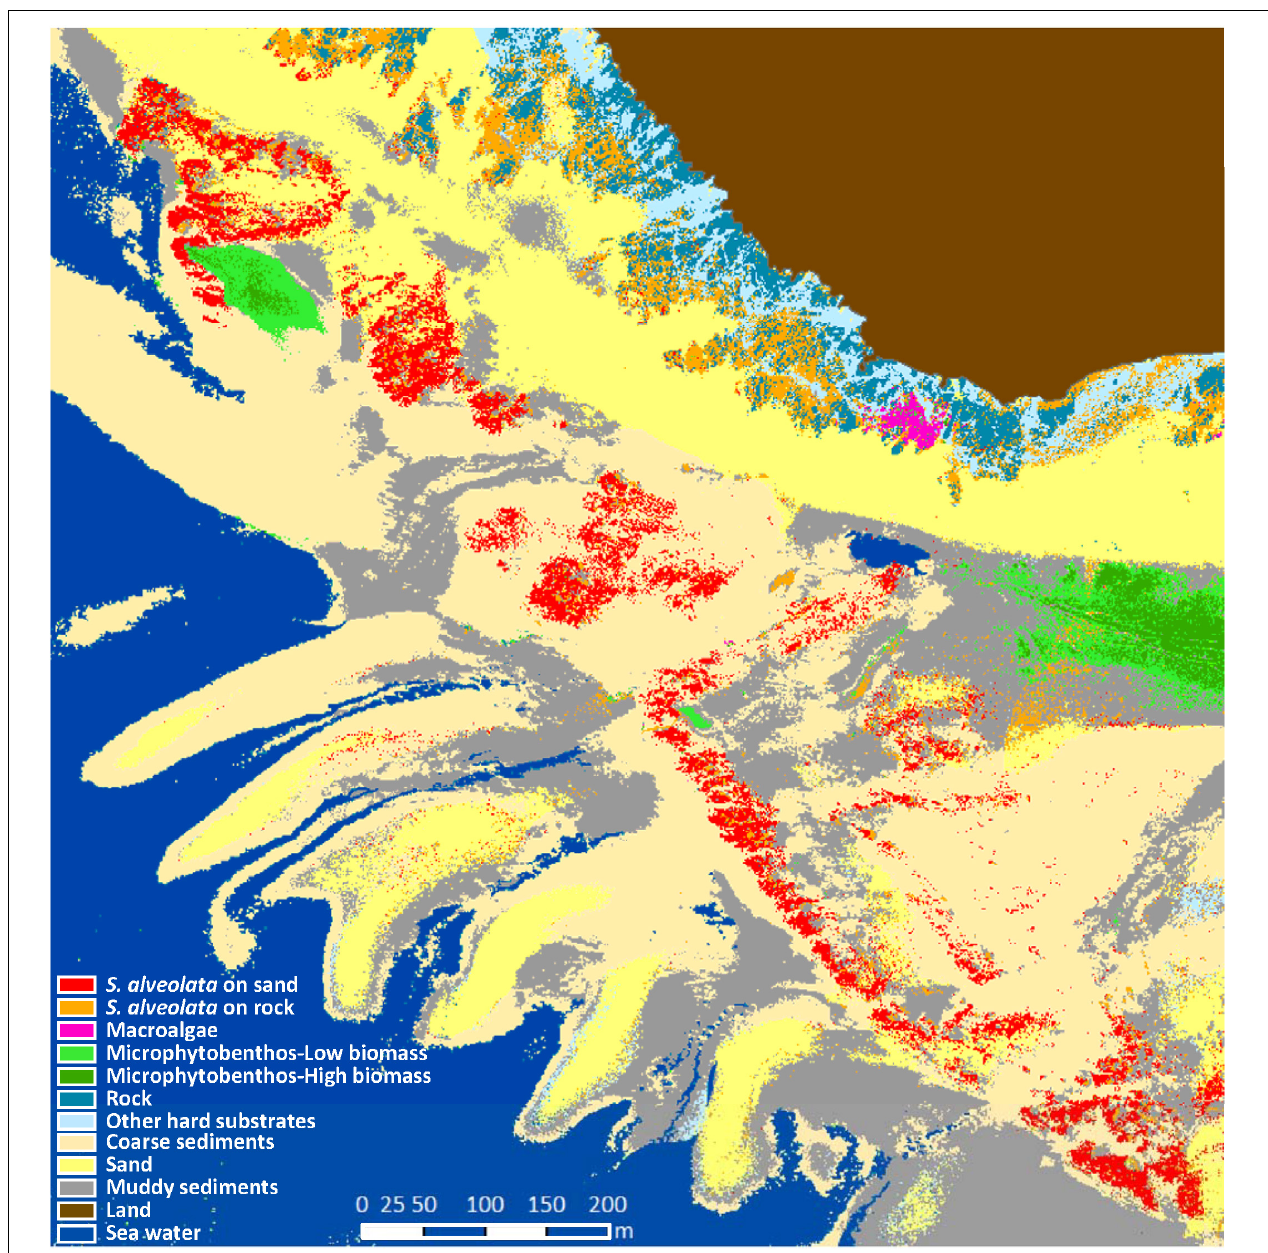
FIGURE 6 | Benthic habitat map of Champeaux site obtained from the hyperspectral airborne imagery using supervised classification based on Mahalanobis